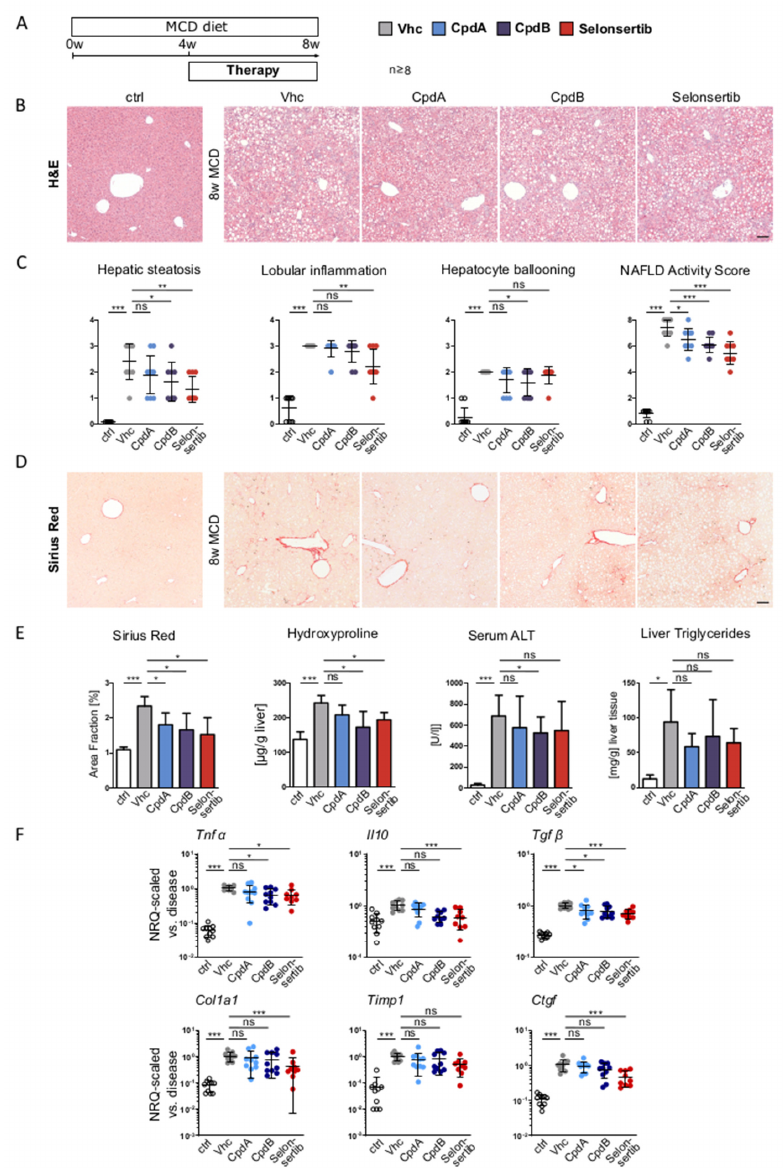
Figure 4. Pharmacologic inhibition of GPR84 ameliorates steatohepatitis and fibrosis in MCD diet-induced fatty liver disease. ( A ) Mice ( n ≥ 8) were fed with a methionine choline deficient (MCD) diet for a period of 8 weeks. Oral pharmacological therapy was conducted over the last 4 weeks of liver injury induction with the two GPR84 antagonists (30 mg/kg BW, PO q.d.) and Selonsertib (15 mg/kg BW, PO b.i.d.) as a positive control. ( B ) Liver histology was evaluated based on H&E stainings, showing severe fibrosing steatohepatitis in MCD fed animals. ( C ) The NAFLD activity score (NAS) was assessed by an external expert pathologist (Histalim), revealing a significantly reduced NAS upon GPR84 or ASK1 inhibition. ( D ) Liver fibrosis was assessed by Sirius-Red-stained liver sections (red: extracellular matrix deposition). ( E ) Quantification of liver fibrosis by Sirius-Red-stained areas and hepatic hydroxyproline content, liver injury by serum ALT and steatosis by hepatic triglyceride concentrations. ( F ) Inflammation- and fibrosis-related gene expression in total liver measured by RT-qPCR. All images were taken at × 10 magnification; scale bar, 100 µ m. Data are presented as mean ± SD based on n ≥ 8 per group. * p < 0.05, ** p < 0.01, *** p < 0.001 (one-way ANOVA). Abbreviations: CpdA / B, compound A / B; Vhc, vehicle; Tnf α , tumor necrosis factor alpha; Il10, interleukin 10; Tgf β , transforming growth factor beta; Col1a1, collagen type I, alpha 1; Timp1, tissue inhibitor of metalloproteinases 1; and Ctgf, connective tissue growth